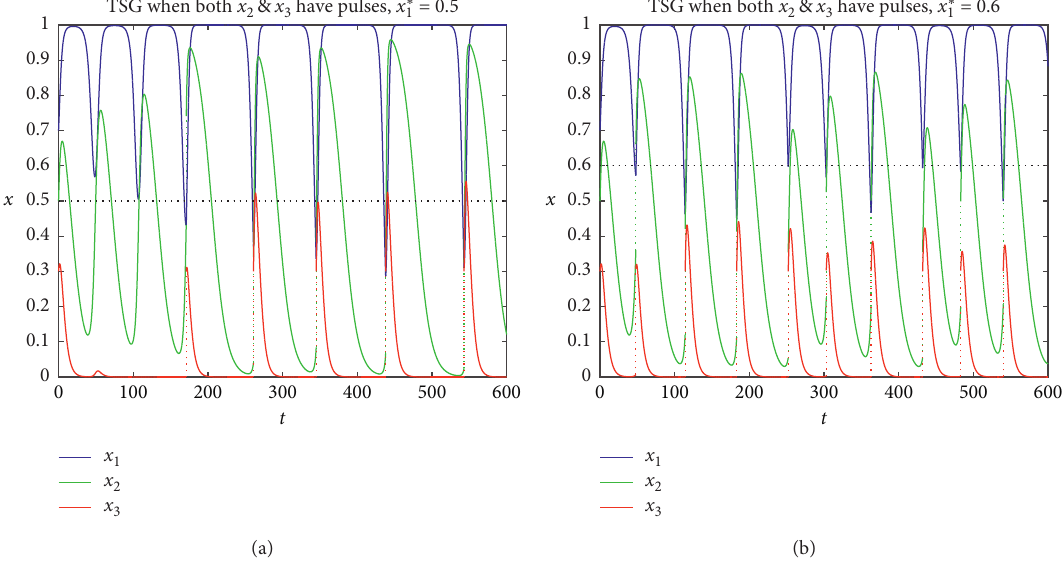
Figure 5: TSGs of DIDEs (2) when both x � 0 . (b) x ∗ 1